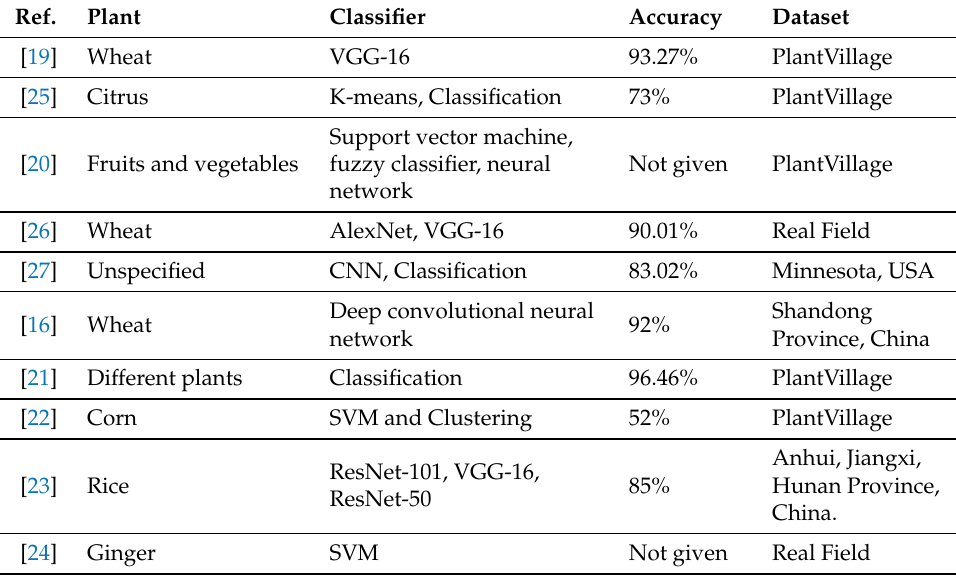
Table 1. Summary of the literature